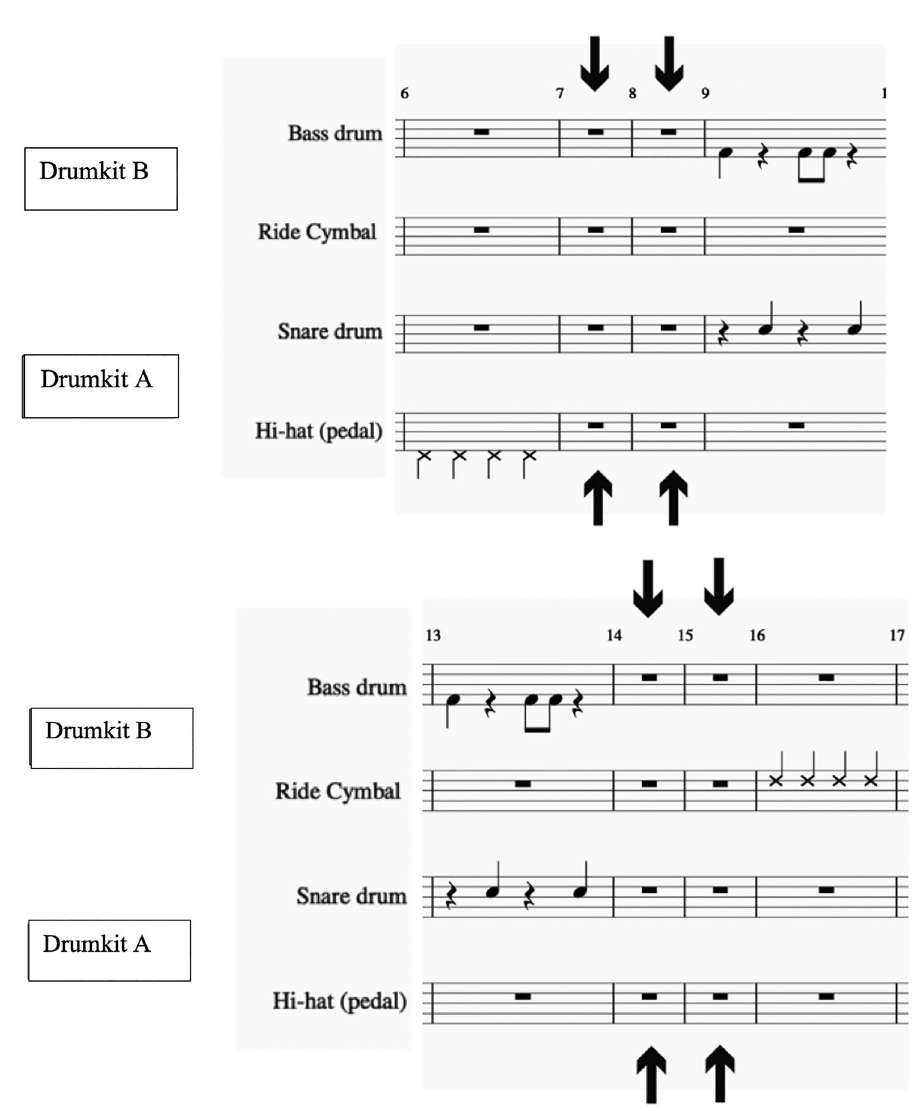
Figure 2. Stimulus 2: pauses at bars 7–8 and 14–15. The score was generated with the notation software MuseScore (www. muses core. org, version